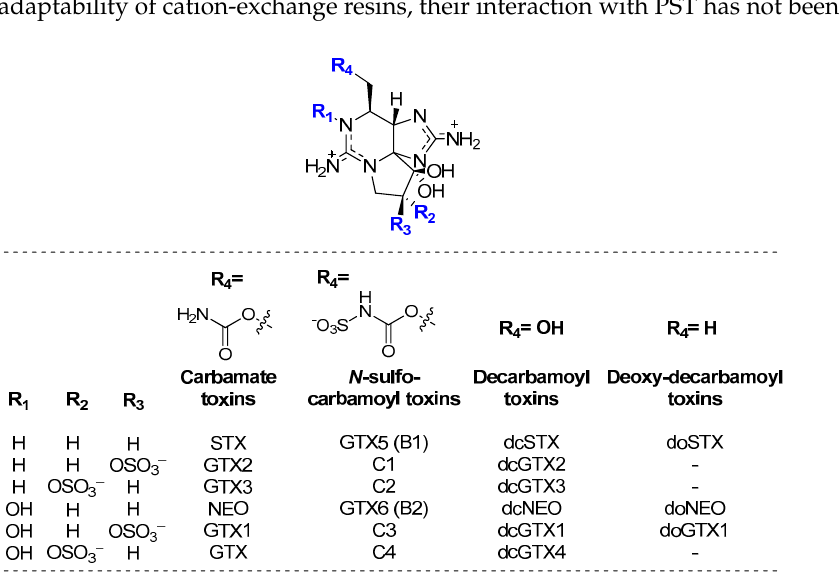
Figure 1. Structure representations of the major STX derivatives (PST group), with the positive charge fully delocalized over the pyrimidine and imidazole groups.